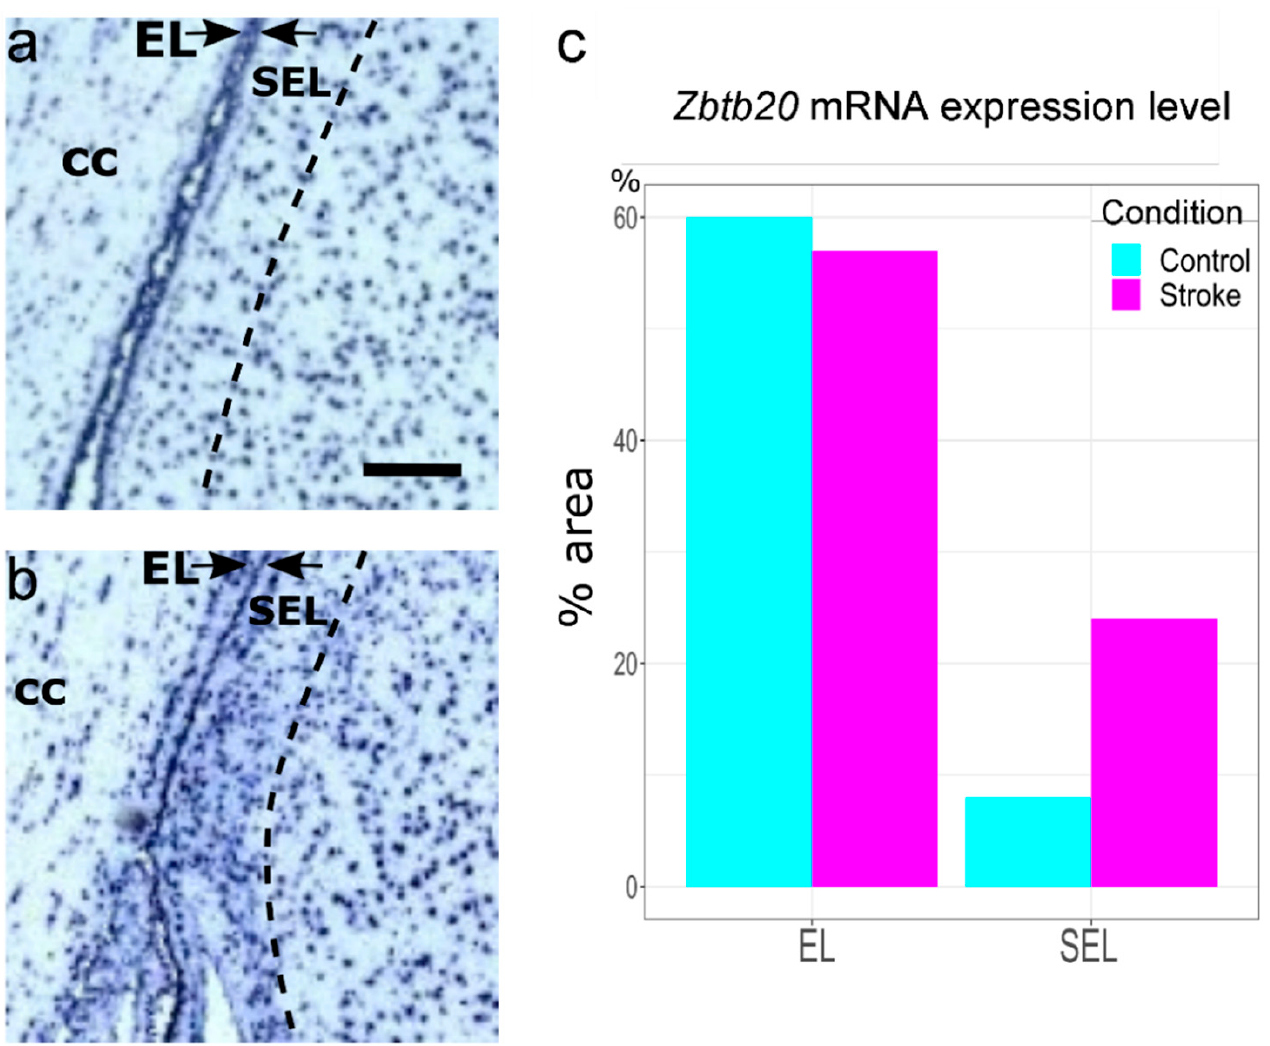
Figure 4. Increased expression of ZBTB20 mRNA in adult macaque monkey SVZa following ischemia. ( a ) Control SVZa; ( b ) ischemic SVZa. The images were extracted from the www.monkey-niche.org public database [30]. A marked enhancement of the ZBTB20 mRNA signal is seen in the SEL following ischemia, confirmed by quantitative assessment using the Celldetekt software ( c ). Scale = 200 μ m. CC—corpus callosum.